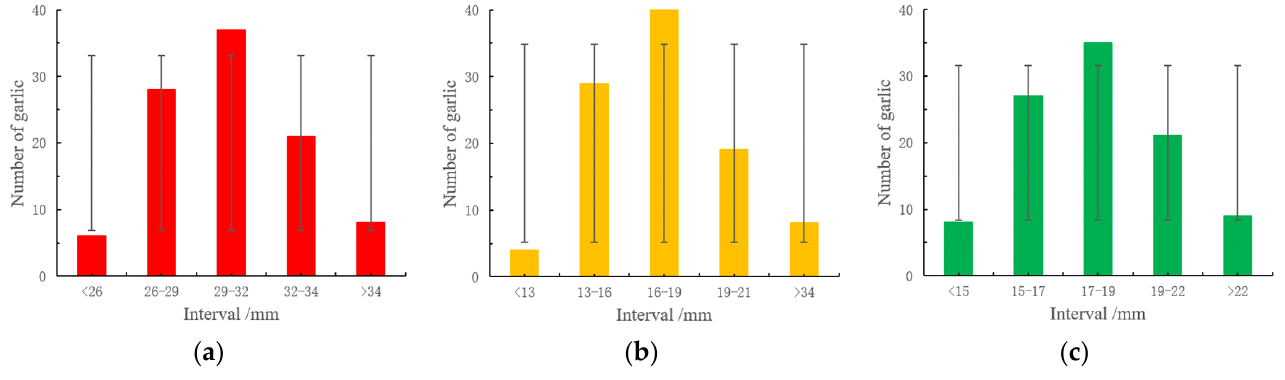
Figure 3. Garlic triaxial size distribution chart. ( a ) Distribution of length; ( b ) Distribution of width; ( c ) Distribution of